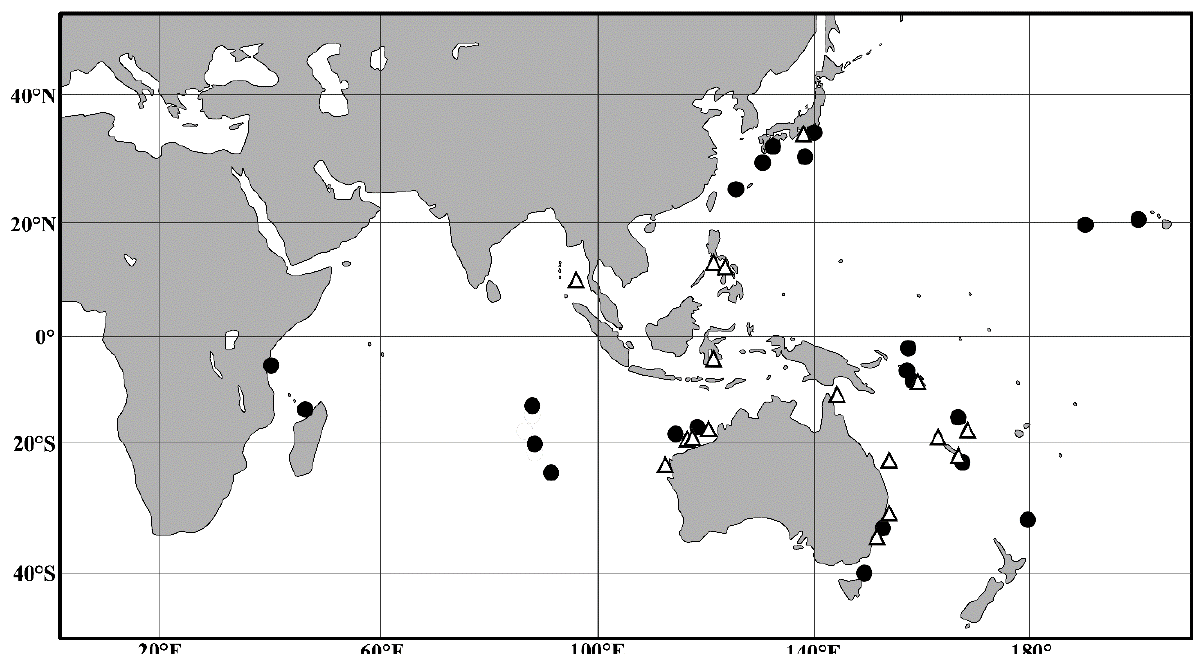
Figure 6. Distribution map of H. bathyoeros (black dots) and H. nasuta (open triangles). One dot may represent more than one capture.